Question: Compose a caption that would accompany this figure in a paper.
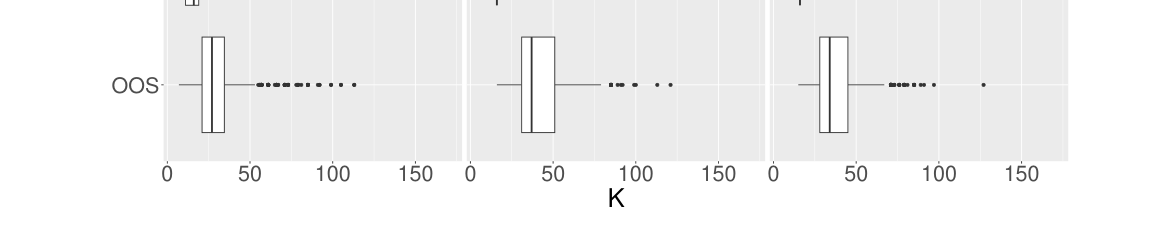
Answer: Simulation 2: boxplots for K (number of parameters) for the models selected by each objective function.